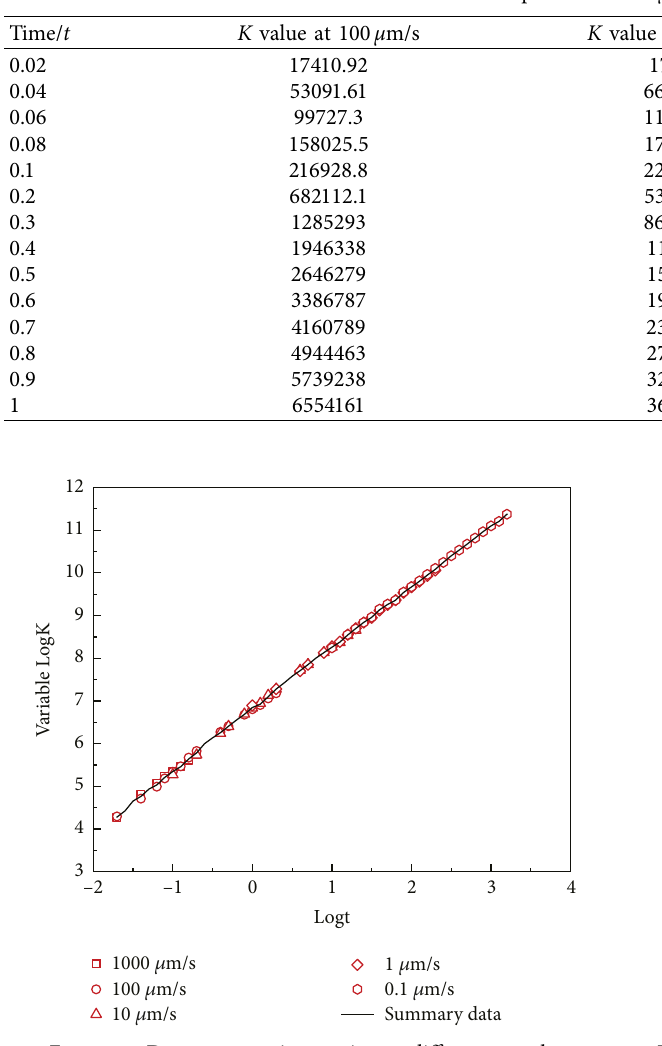
Figure 9: Data fitting diagram of ramp-constant strain history.